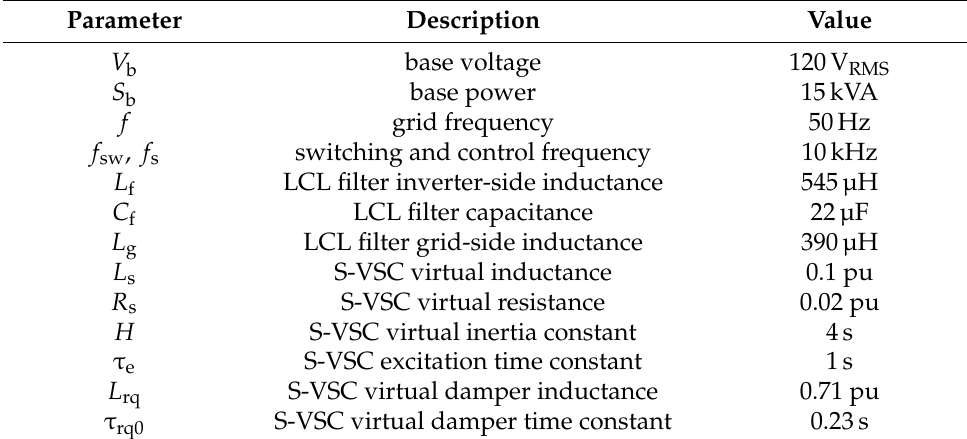
Table 1. Inverter and S-VSC parameters for the experimental